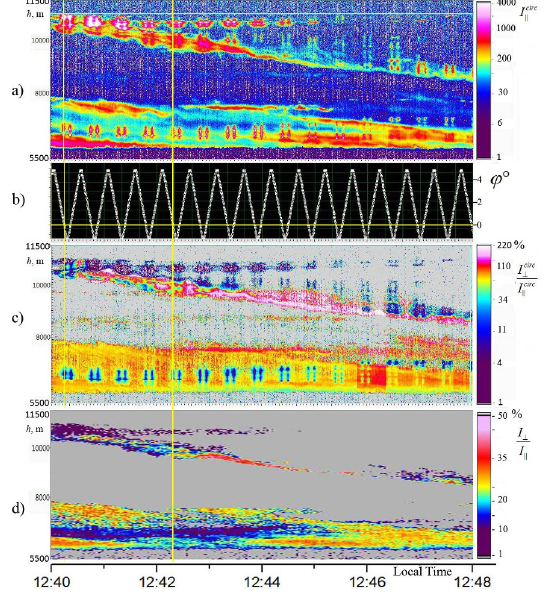
Fig. 2. Cloud structure, observed with zenith scanning Figure 2 shows the lidar data for 01.10.2018. The tilte angle is shown in Fig.2.b. Upper frame (2.a) indicates the parallel component circ I (circular initial polarization) in ADC codes (0- 4096). Fig. 2c shows the depolarization ratio I I δ = . Positions of vertical orientation α=0 ⊥ (cid:2) (one of them is indicated with yellow line) are minimal δ . The bottom frame 2d (depolarization ratio for linear polarization) shows the record from lidar LOSA-S, placed near the LOSA-M3 lidar and permanently oriented